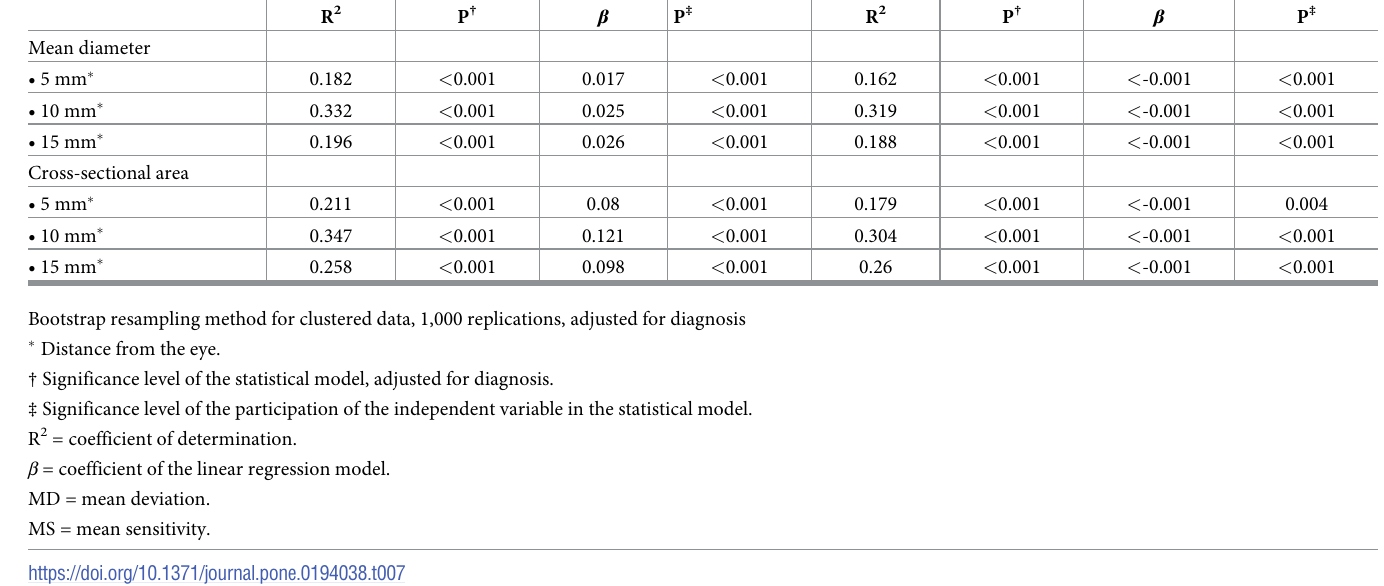
Table 7. Structure-function relationship between 3-Tesla magnetic resonance imaging findings of the intraorbital optic nerve and frequency doubling technology outcomes. Intraorbital Optic Nerve